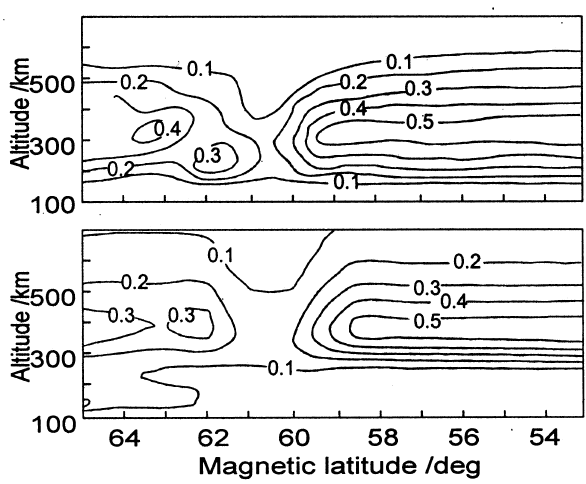
Fig. 6. Contour patterns of the electron density ( × 10 12 m − 3 ) over the chain of receivers in Russia at 18:04 UT on 7 April 1990. The top panel shows the reconstruction obtained by means of the phase- difference tomography. The calculated pattern (bottom panel) is obtained using the three-dimensional ionospheric model. The x - axis indicates the magnetic latitude (degrees), increasing to the